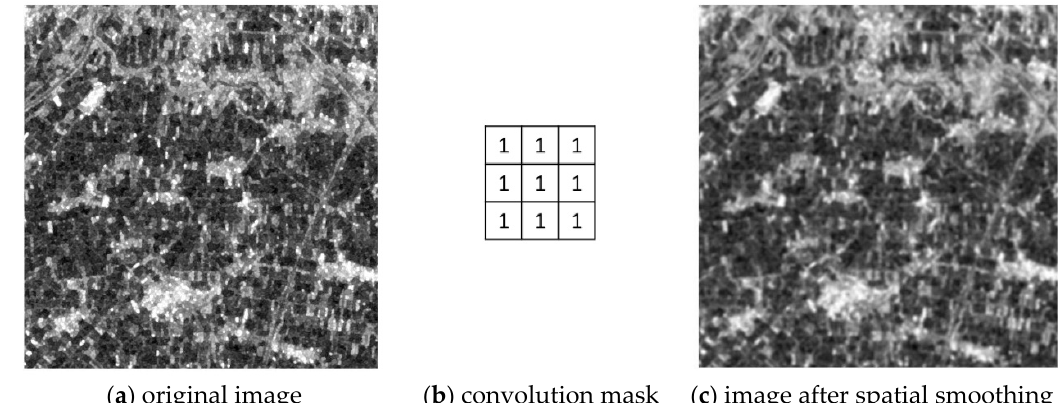
Figure 3. Example of spatial smoothing. ( a ) is the original input image, ( b ) is the convolution mask and ( c ) is the image after spatial smoothing.